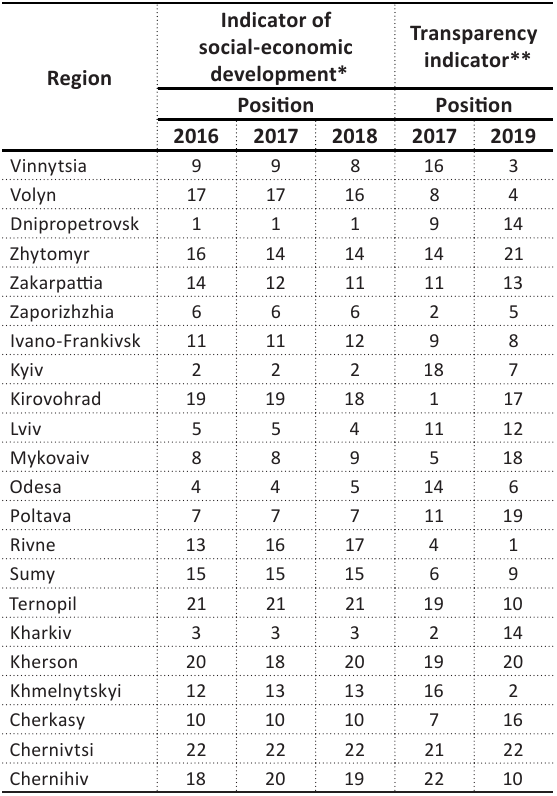
Table 2. Distribution of regions by level of socio- economic development and